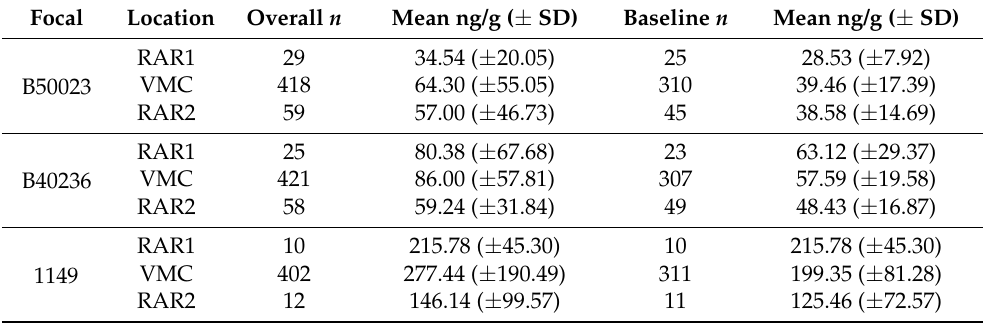
Table 2. Orangutan descriptive fecal glucocorticoid metabolite (fGM) data by individual and location. “Overall n ”: all fecal samples collected over the observational period. “Baseline n ”: number of fecal samples after the removal of all fecal samples >2 standard deviations (SD) above the mean.